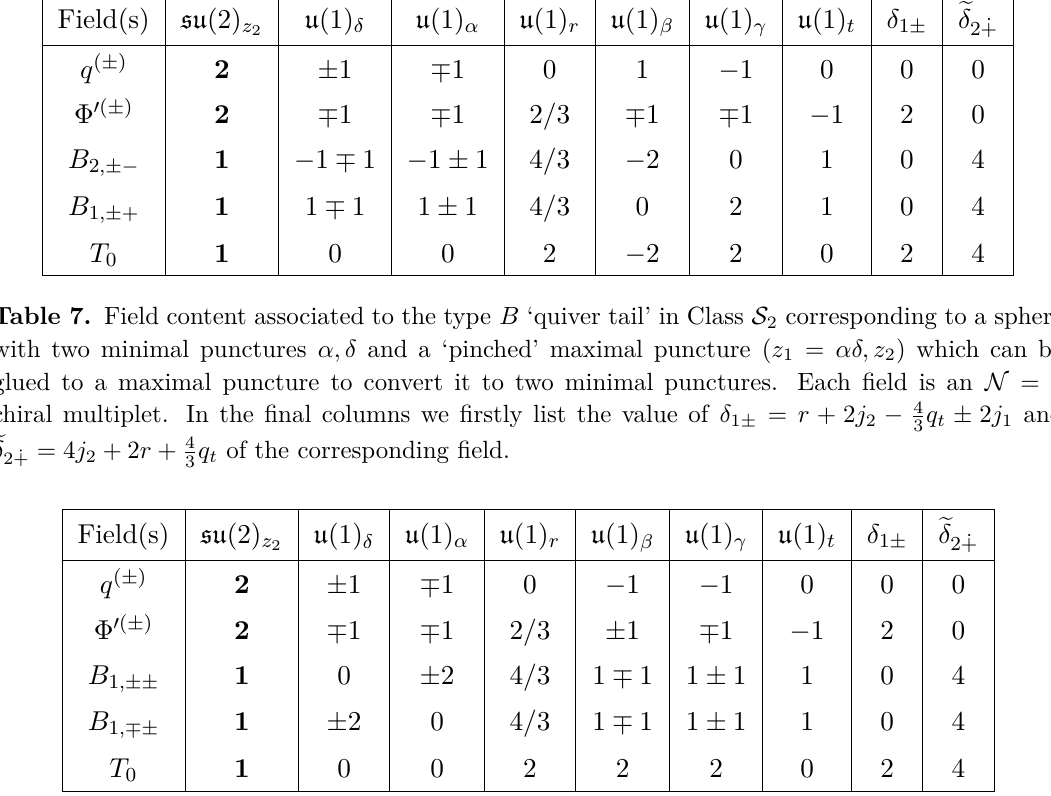
Table 8. Field content associated to the type A ‘quiver tail’ in Class S 2 corresponding to a sphere with two minimal punctures α, δ and a ‘pinched’ maximal puncture ( z glued to a maximal puncture to convert it to two minimal punctures. Each field is an N = 1 chiral multiplet. In the final columns we firstly list the value of δ q t of the corresponding e δ 2 ˙+ = 4 j 2 + 2 r + 4 3